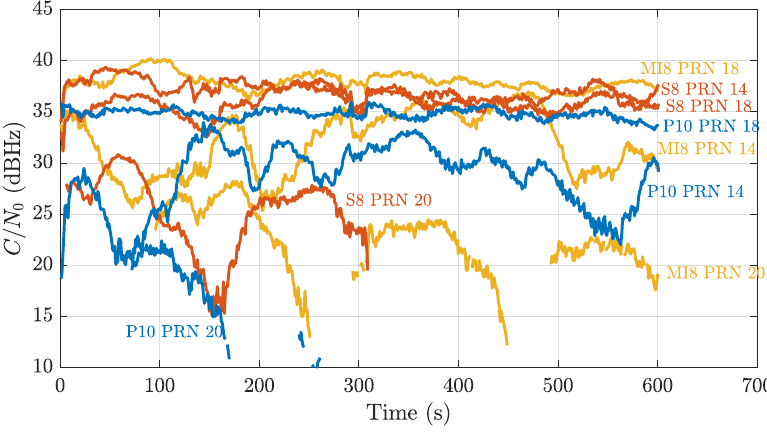
Figure 2. Comparison of the C / N 0 of three different satellites (low, medium, and high-elevated Pseudo Random Noises (PRNs)), as estimated by the three different